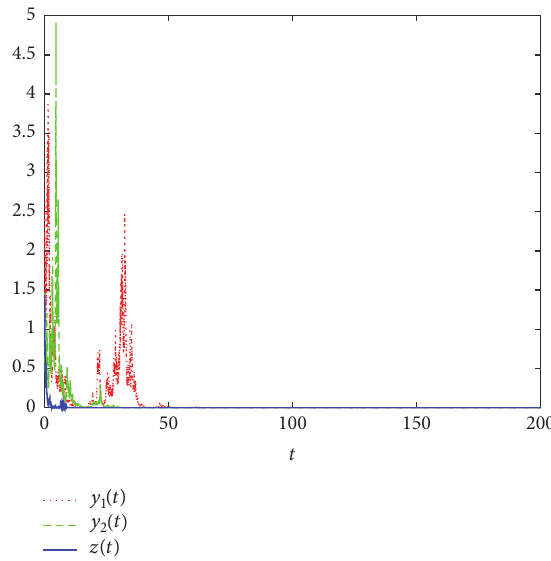
= 0 (𝑖 = 1, 2, 3, 4, 5) . 𝑖